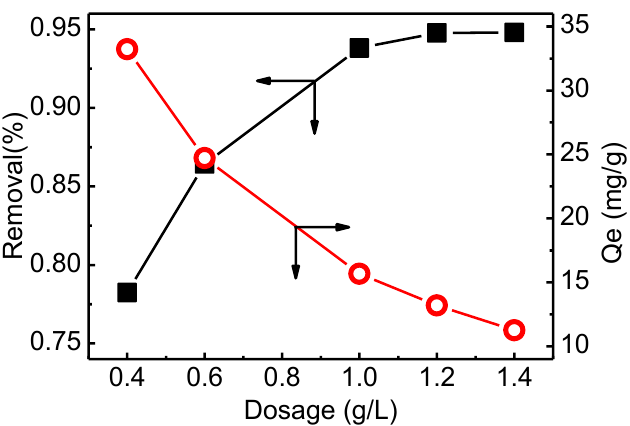
Figure 7. Effect of adsorbent dosage on the removal efficiency and adsorption capacity of phosphate by QCLF adsorbent (initial concentration 20 mg/L, volume 50 mL, pH 7, adsorption time 24 h).